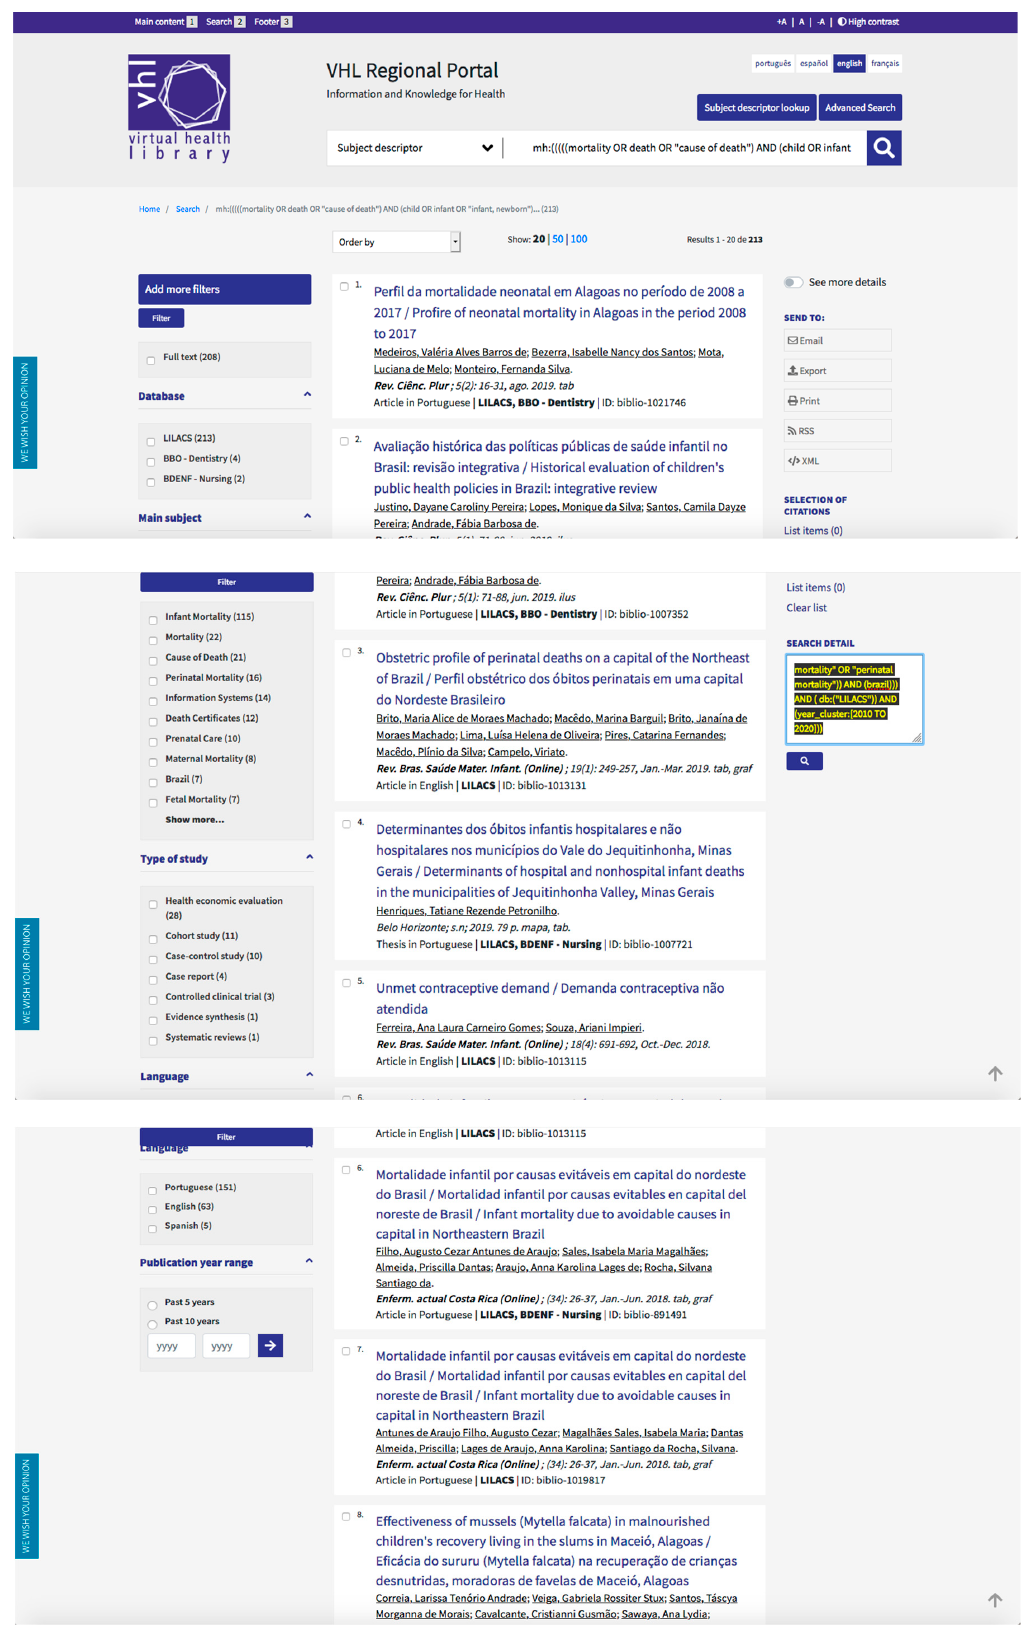
Figure A3. Screen shot research LILACS. Concept 2. Table A4. Research SCIELO (1206 references).